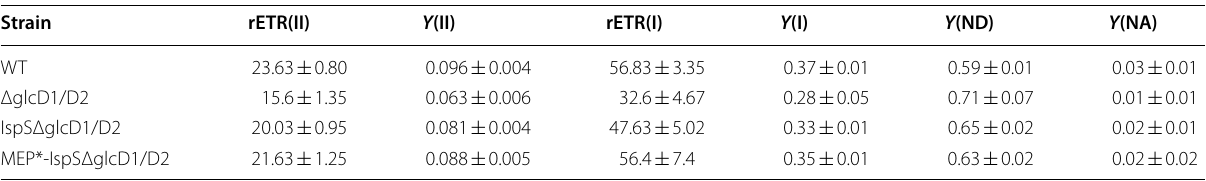
Table 2 Measurement of chlorophyll fluorescence kinetics for photorespiration-impaired strains and WT under 588 μmol